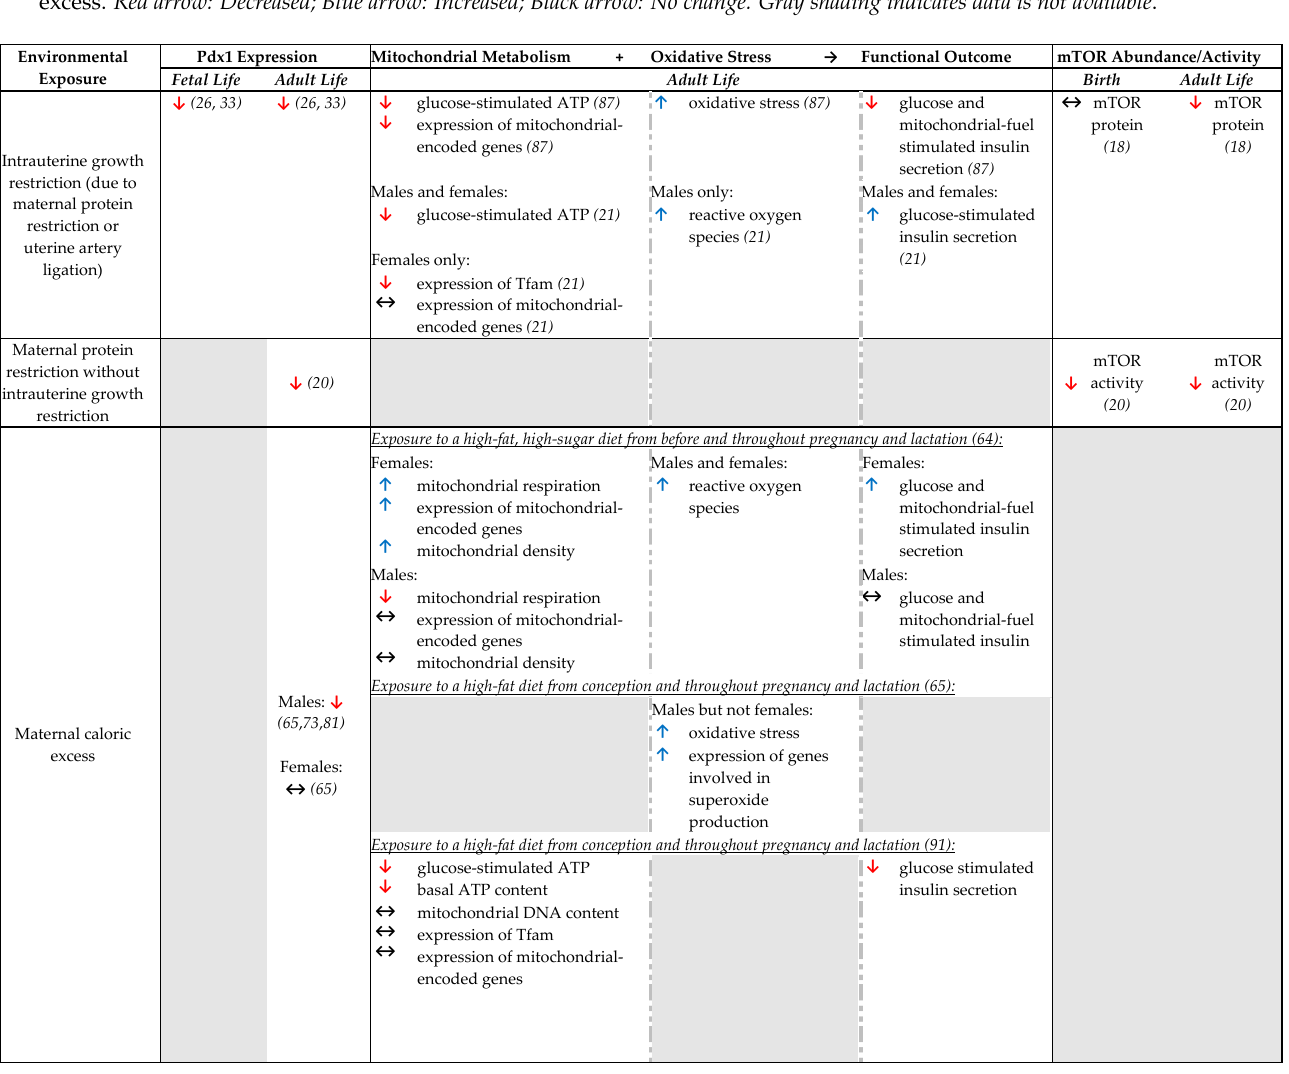
Table 1. Similarities and differences in the mechanisms identified in offspring exposed to restricted nutrition versus caloric excess. Red arrow: Decreased; Blue arrow: Increased; Black arrow: No change. Gray shading indicates data is not available .